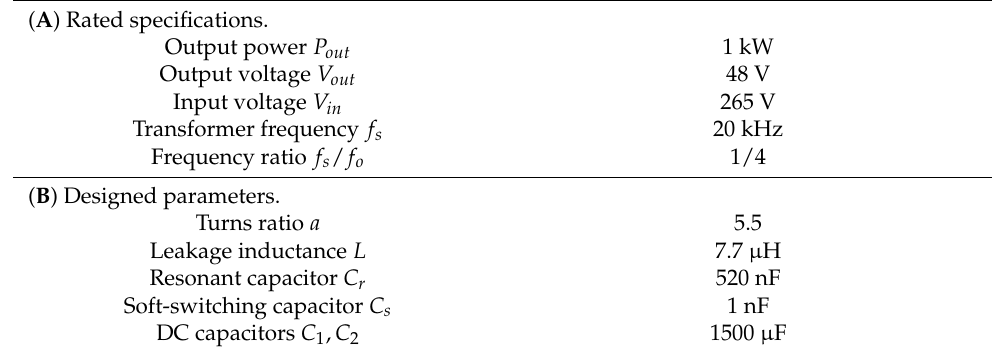
Table 3. Specifications and designed parameters of proposed SR–SAB